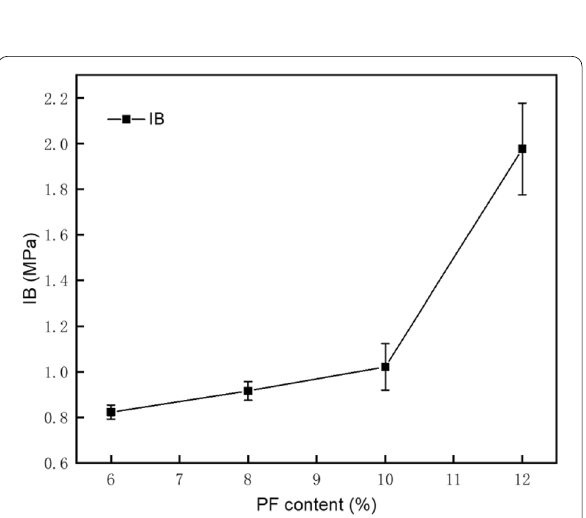
Fig. 5 IB at different PF content with 1% AC foaming